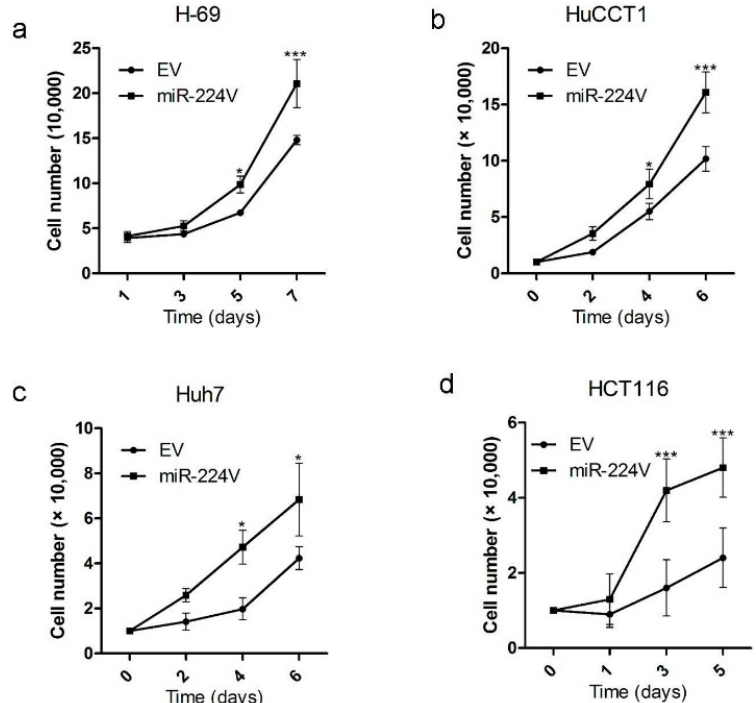
Figure 2. Cells display increased growth upon modest miR-224 upregulation through infection with MIEG3-miR-224.H-69 ( a ), HuCCT1 ( b ), Huh7 ( c ), and HCT116 (-) ( d ); cells were counted at different days after plating of MIEG3-miR-224 (miR-224V) or MIEG3-EV (EV) cells, respectively. Cell counts × 10 4 of cells at days indicated infected with miR-224V (squares) or the EV (circles). For every treatment and every time point, the data presented are the average of five independently counted wells. Mean ± SD, * p < 0.05, *** p <